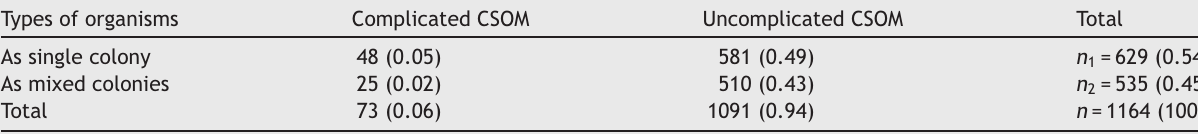
Numbers of growing organisms from cultures of ear discharge samples in patients with complicated and uncomplicated CSOM.